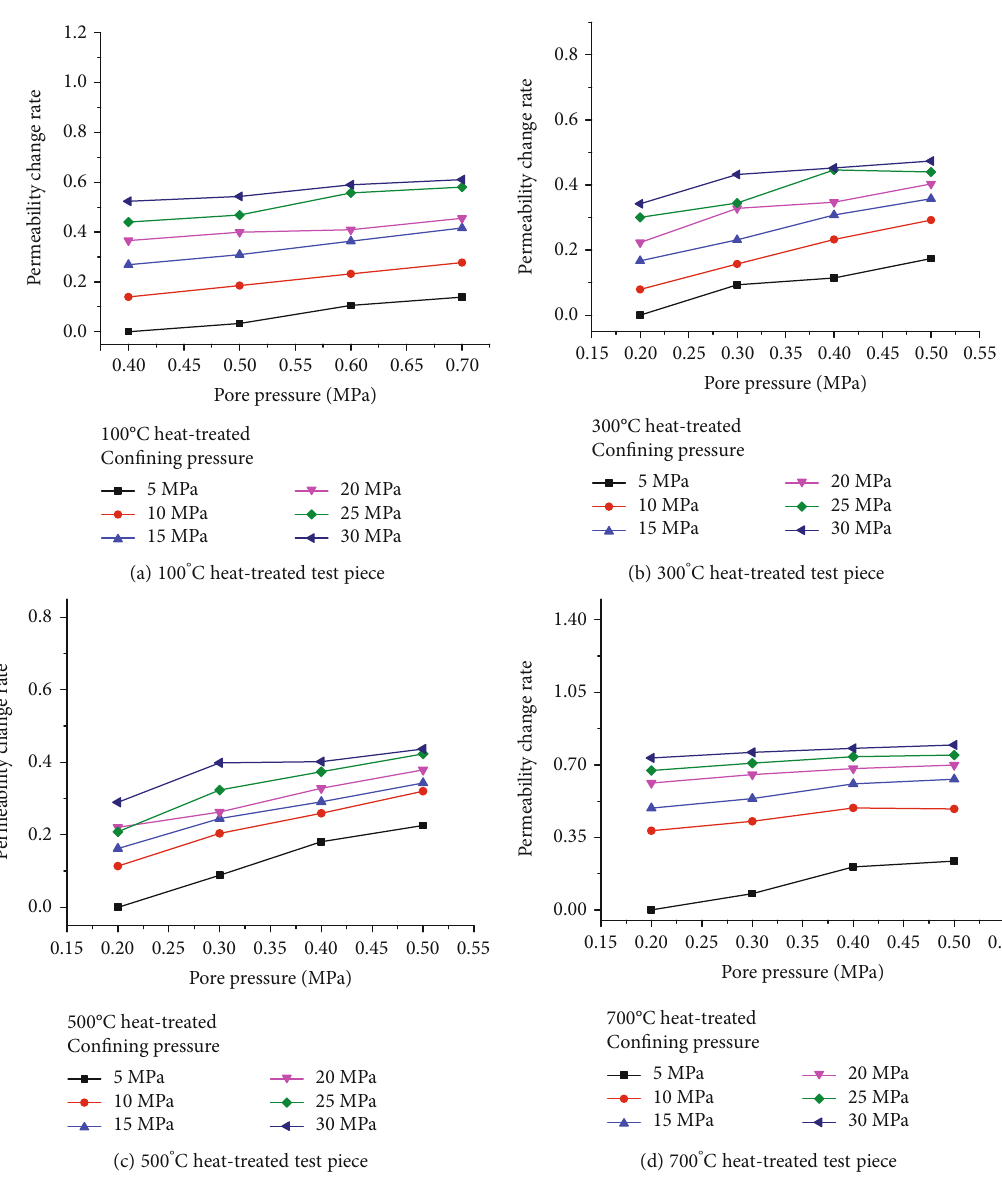
Figure 8: Permeability change rate curves under various pore pressure